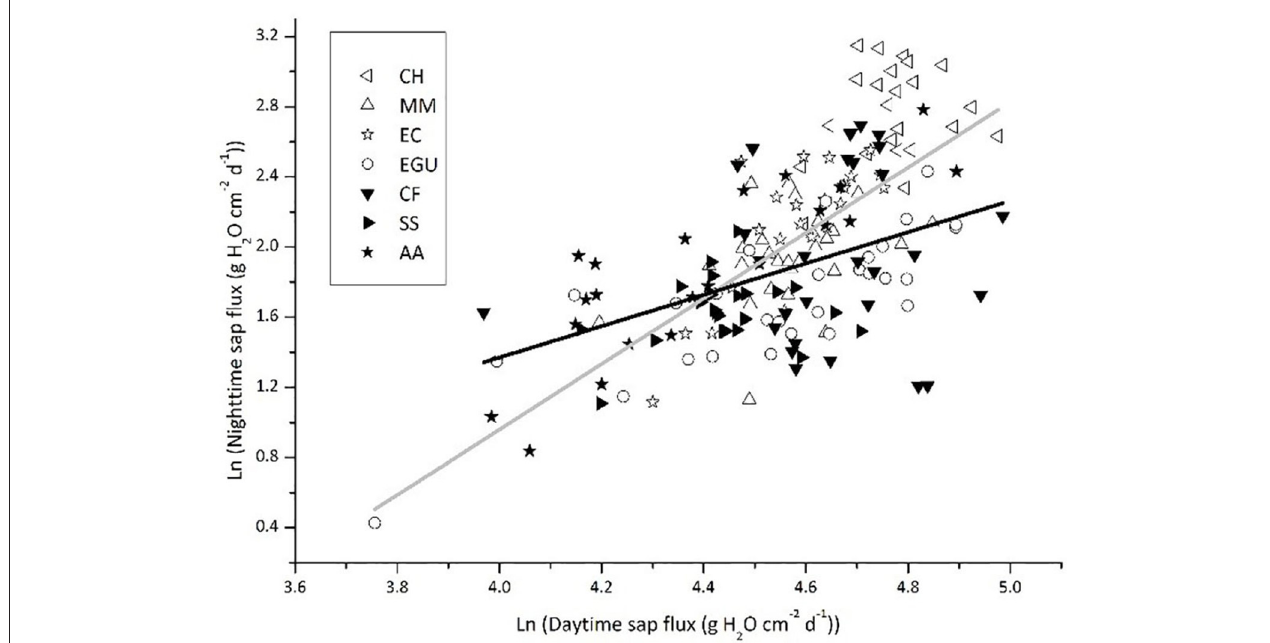
FIGURE 3 | Nighttime sap flux as a function of daytime sap flux in trees with or without stem photosynthesis. The sap flux values reported for each species are the means of 3–5 trees. The solid gray line represents the standardized major axis regression across the four species with stem photosynthesis: y = 2.680x – 10.261 ( r 2 = 0.485, P < 0.0001); the solid black line represents the standardized major axis regression across the three species without stem photosynthesis: y = 1.943x – 6.936 ( r 2 = 0.211, P < 0.0001).